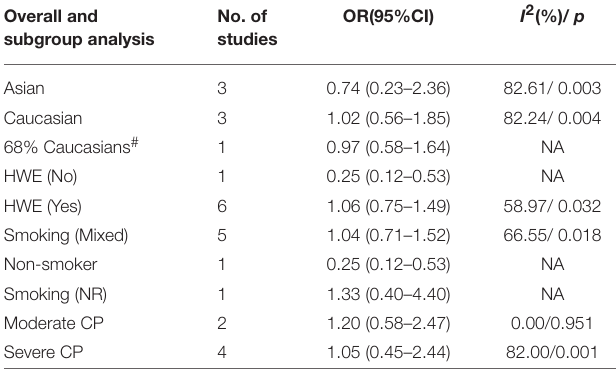
TABLE 3 | Overall and subgroups meta-analysis of unadjusted